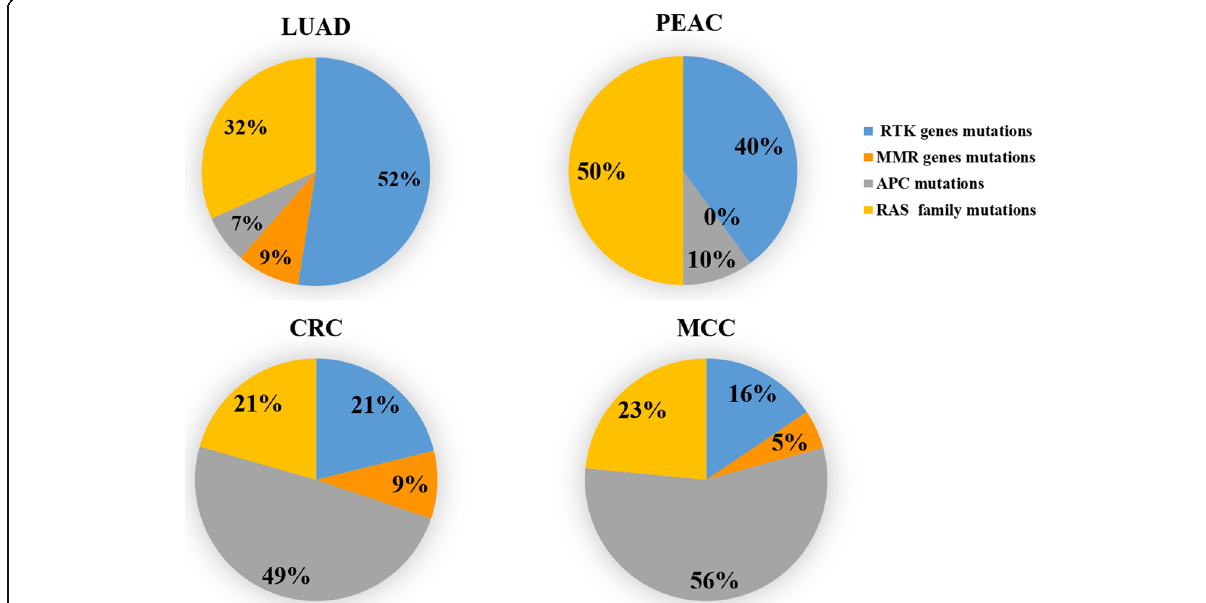
Fig. 3 Functional enrichment analysis in the PEAC cohort and comparison with TCGA and the MSKCC databases. CRC, colorectal cancer; LUAD, lung adenocarcinoma; MCC, metastatic colorectal carcinoma; PEAC, pulmonary enteric